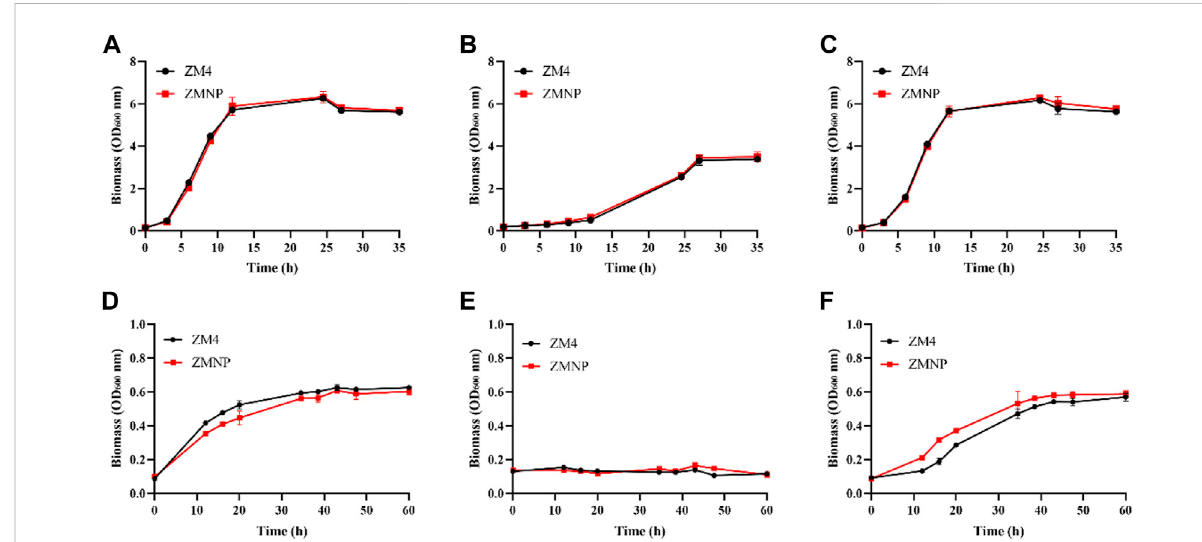
FIGURE 5 Cell growth of ZM4 and ZMNP responding to different inhibitors. RM (A) and RM supplemented with furfural (RMF) (B) , or ethanol (RME) (C) , as well as MM (D) and MM supplemented with furfural (MMF) (E) , or ethanol (MME) (F) were set up to evaluate the growth of ZM4 and ZMNP. RMF: 2.60 g/LfurfuraltreatmentinRMmedia;RME:47.36 g/LethanoltreatmentinRMmedia.MMF:1.25 g/LfurfuraltreatmentinMMmedia,MME:20 g/L ethanol treatment in MM media. At least two independent experiments were performed with similar results. Values are the mean of one representative experiment with three technical replicates. Error bars represent standard deviations.